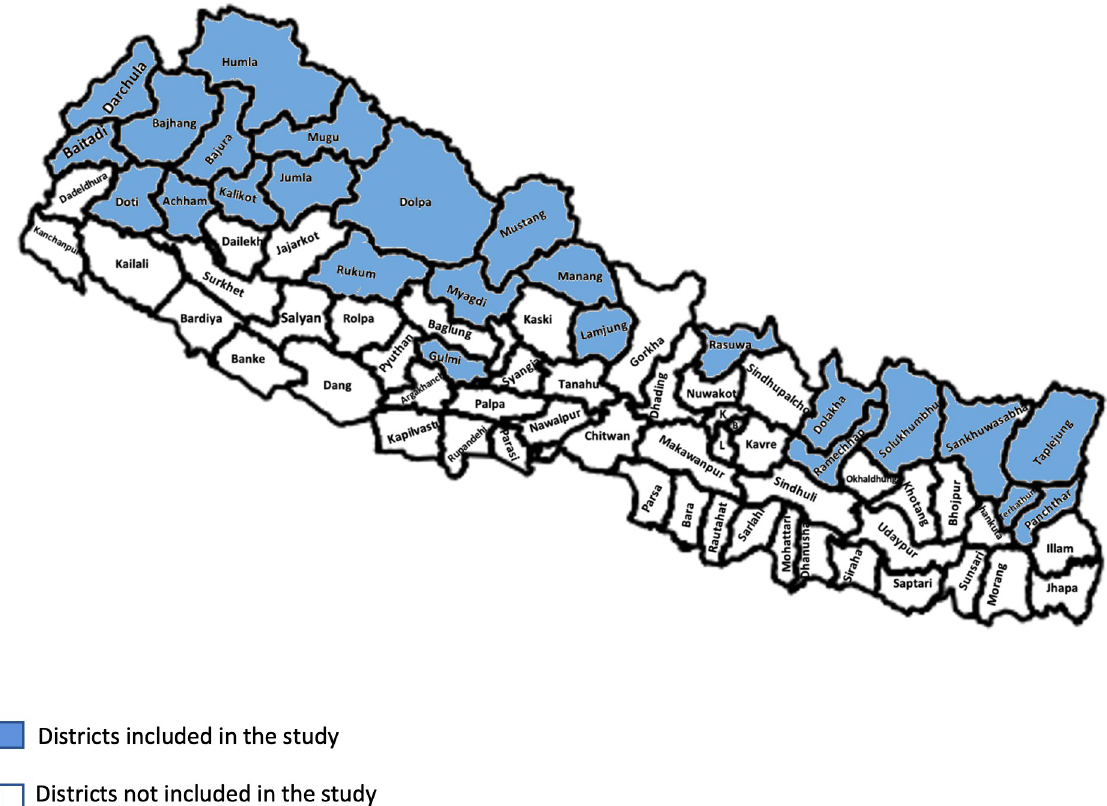
Fig 1. Map of districts selected for the study (blue). (A) License: Creative Commons Attribution–ShareAlike 4.0 International License. Caption Credit: geoBoundaries-NPL-ADM2-PREVIEW.png (640 × 480) (raw.githubusercontent.com). (Accessed December 28, 2022), and Runfola, D. et al. (2020) geoBoundaries: A global database of political administrative boundaries. PLoS ONE 15(4): e0231866. https://doi. org/10.1371/journal.pone.0231866. (Accessed December 28, 2022) [21, 22].